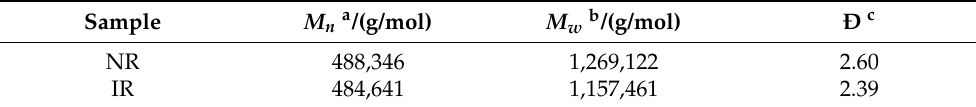
Table 2. Molecular weight and distribution of NR and IR.